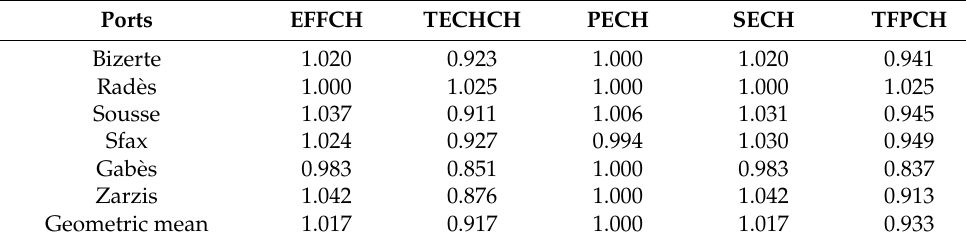
Table 9. Overall factor productivity index and its components per port